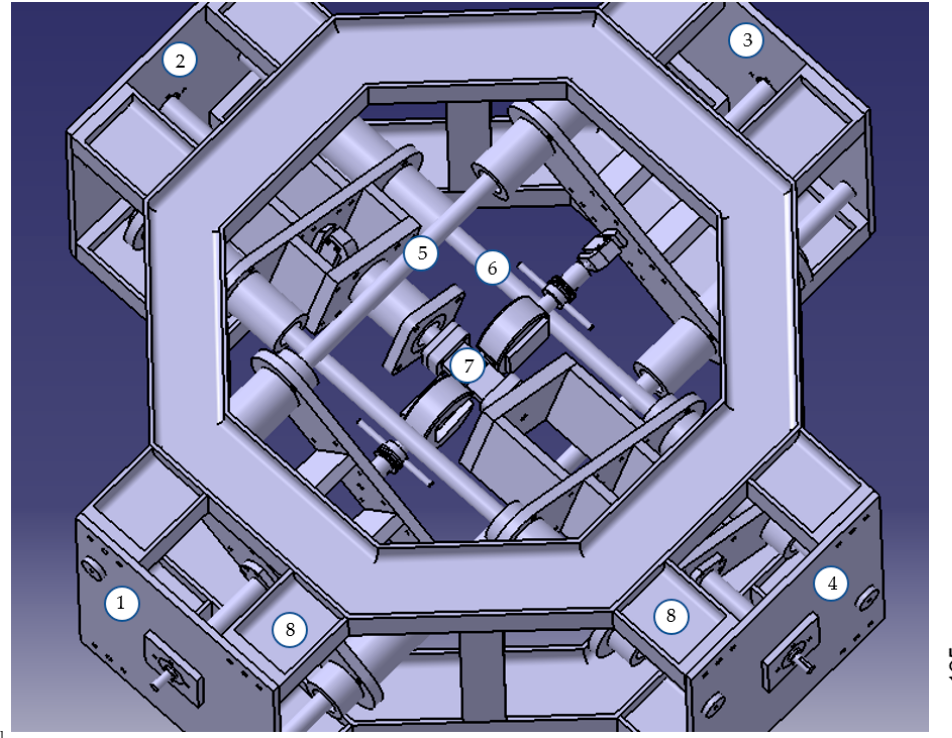
Figure 3. Equipment overview for compressive testing: (1–4) lateral plates; (5,6) axis; (7) sample for compressive test; (8) lateral support.